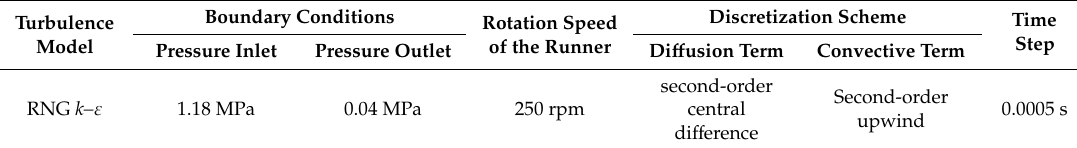
Table 2. Numerical setting parameters.